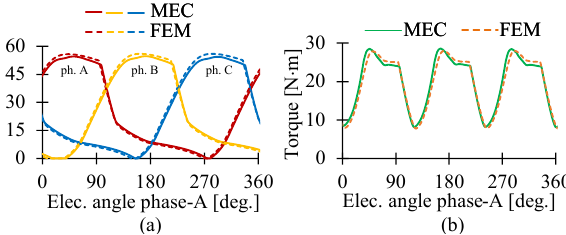
Figure 23. Dynamic characteristics at 7000 r/min at 385 V DC: ( a ) phase currents I ref = 55 A, θ ON = − 79 ◦ , and θ OFF = 100 ◦ and ( b ) developed electromagnetic torque.